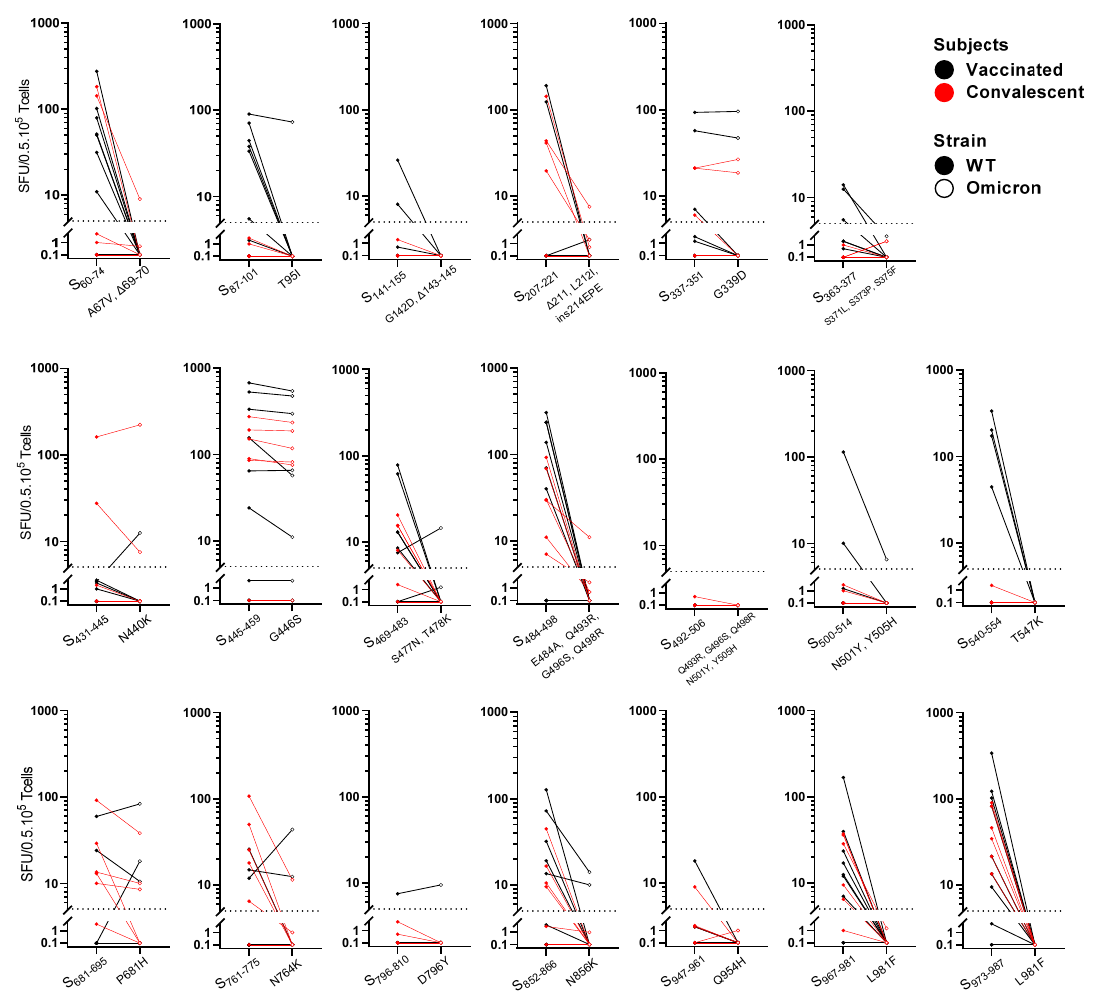
Figure 5. Functional impact of Omicron BA.1 mutations on individual spike-epitope-specific T cells of vaccinated and convalescent subjects. Recognition of individual CD4 + T-cell epitopes of spike protein by polyclonal-epitope-specific T-cell lines in IFN- È ELISPOT assay. T-cell lines were generated by 14-day in vitro stimulation of PBMCs from vaccinated (black dots/lines) and convalescent individuals (red dots/lines) with a pool of selected CD4 + T-cell epitope candidates from the D614G wild-type (WT) strain (“WT CD4 + pool”) in the presence of IL-2. Subsequently, cells were stimulated for 24 h with 20 individual CD4 + T-cell epitopes of spike protein of WT strain versus corresponding sequences of the Omicron BA.1 variant. Each pair of dots connected with line represents SARS-CoV-2-specific IFN- È + T-cell response of one subject responding to an individual WT (closed dots) versus Omicron BA.1 peptide (open dots). On the Y -axis each individual peptide pair is indicated as location of first and last amino acid position within WT spike protein (S), whereas the corresponding Omicron BA.1 sequence is indicated by the location(s) of the amino acid residue(s) that changed compared with the WT sequence. Dotted line indicates threshold for IFN- È -positive responses. SFU—spot forming units.